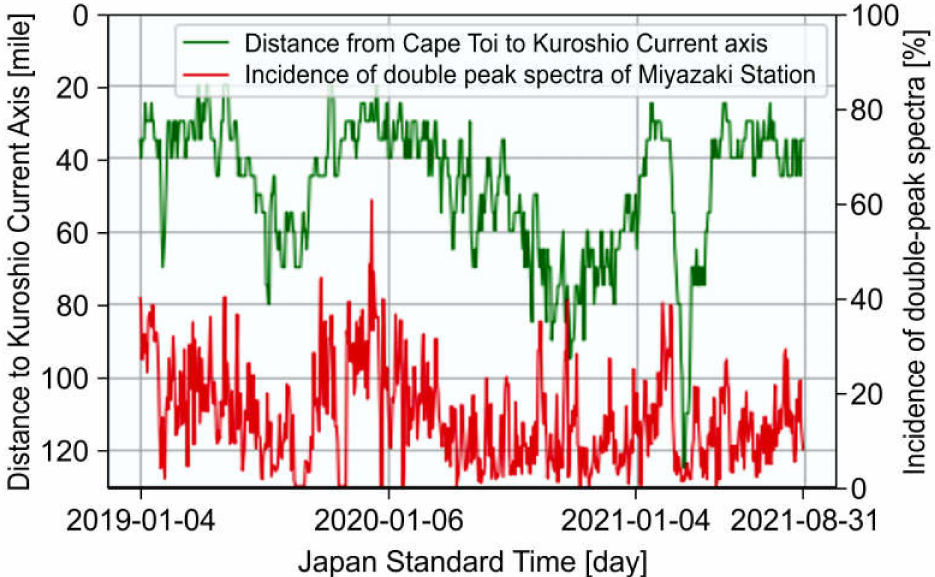
Figure 6. Comparison between the incidence of double-peak spectra and the location of the Kuroshio Current axis. The horizontal axis is the distance to the Kuroshio Current axis. The horizontal axis is the daily change from January 2019 to August 2021. The green line is the distance from Cape Toi to the Kuroshio Current axis according to the Japan Coast Guard. The red line is the incidence of the double-peak spectrum at Miyazaki Station for each day. The period 1 (cid:13) is from March to July 2019. Period 2 (cid:13) is from January to March